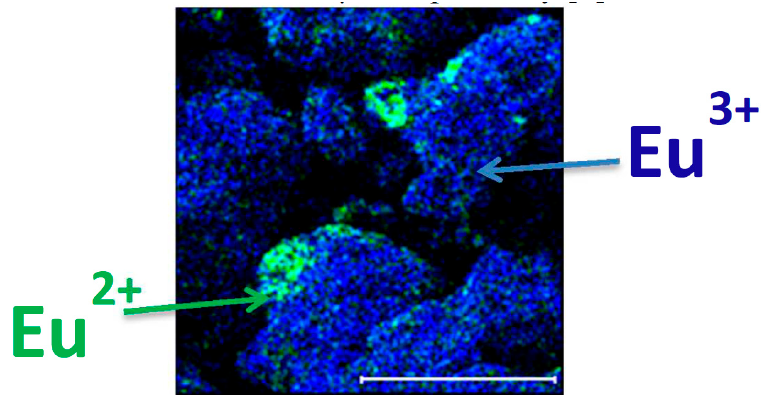
Figure 15. TOF-SIMS chemical imaging indicating the differences in oxidation state and distribution of the Eu 3+ dopant and the Eu 2+ contaminant using a false color overlay of the Eu(II)F + (172 m / z ; green) ion and the Eu(III)F 2+ (191 m / z ; blue) ion [59].